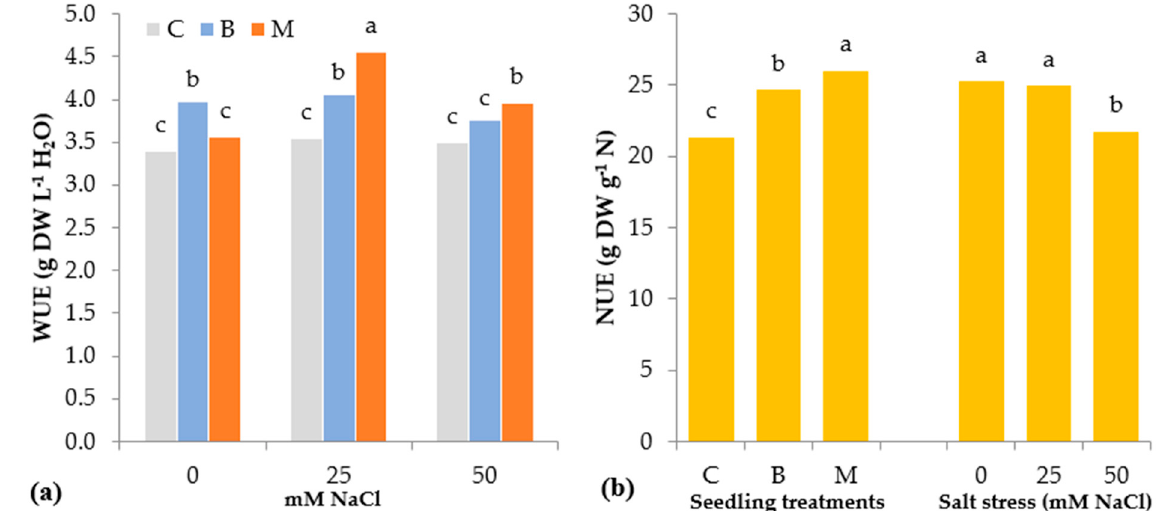
Figure 5 . Effect of the seedling treatments (C, not treated; B, Bactorr S13 ; M, Flortis Micorrize) and salt stress (0, 25, and 50 mM NaCl in the irrigation water) on ( a ) the water use efficiency (WUE) and ( b ) the nitrogen use efficiency (NUE) of tomato seedlings (bars with different uppercase or lowercase letters are significantly different at p < 0.05 according to the LSD test).